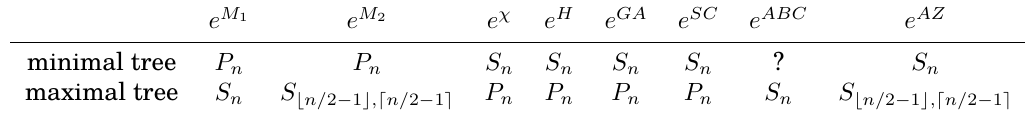
Table 3: Extremal trees for some graphical function-indices with weight-functions being exponential